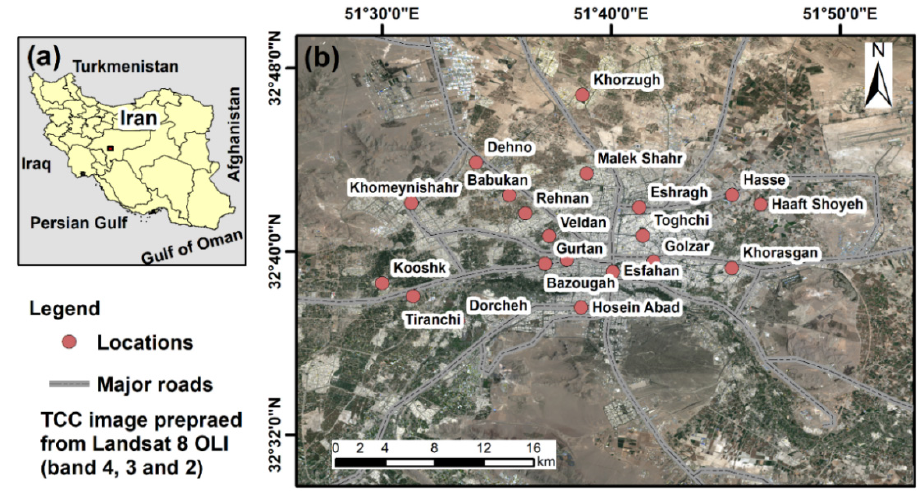
Figure 1. Study area map of ( a ) Isfahan city in Iran map ( b ) Isfahan city and its surrounding area, prepared from true color composite image of Landsat 8 OLI bands (Path/Row: 164/037).